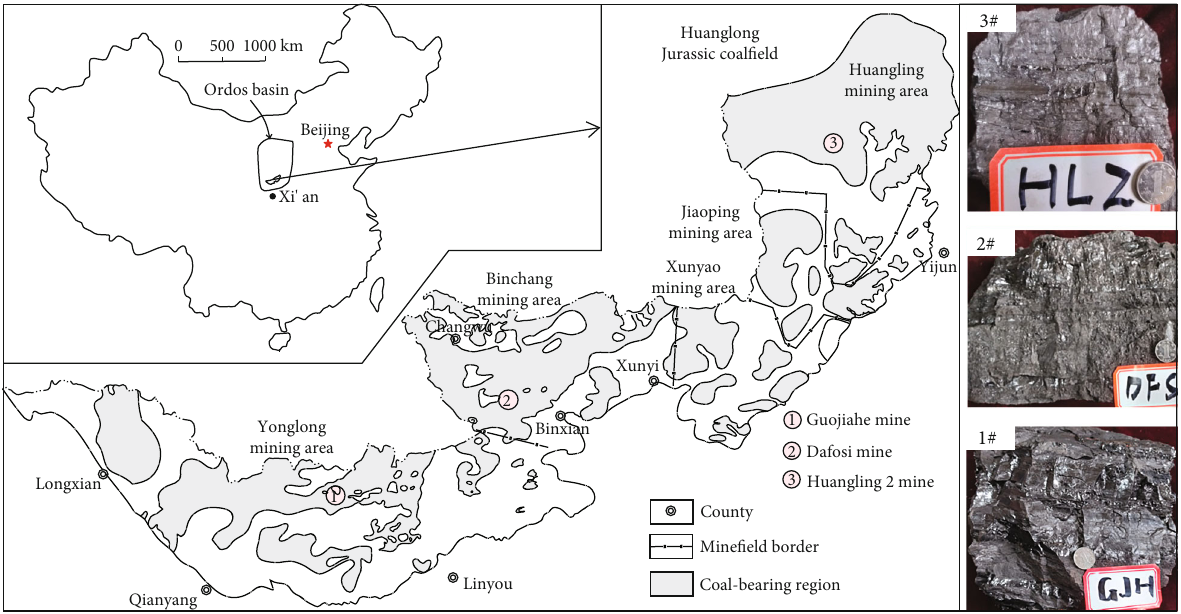
Figure 1: The distribution of the selected samples in the Southern Ordos Basin.